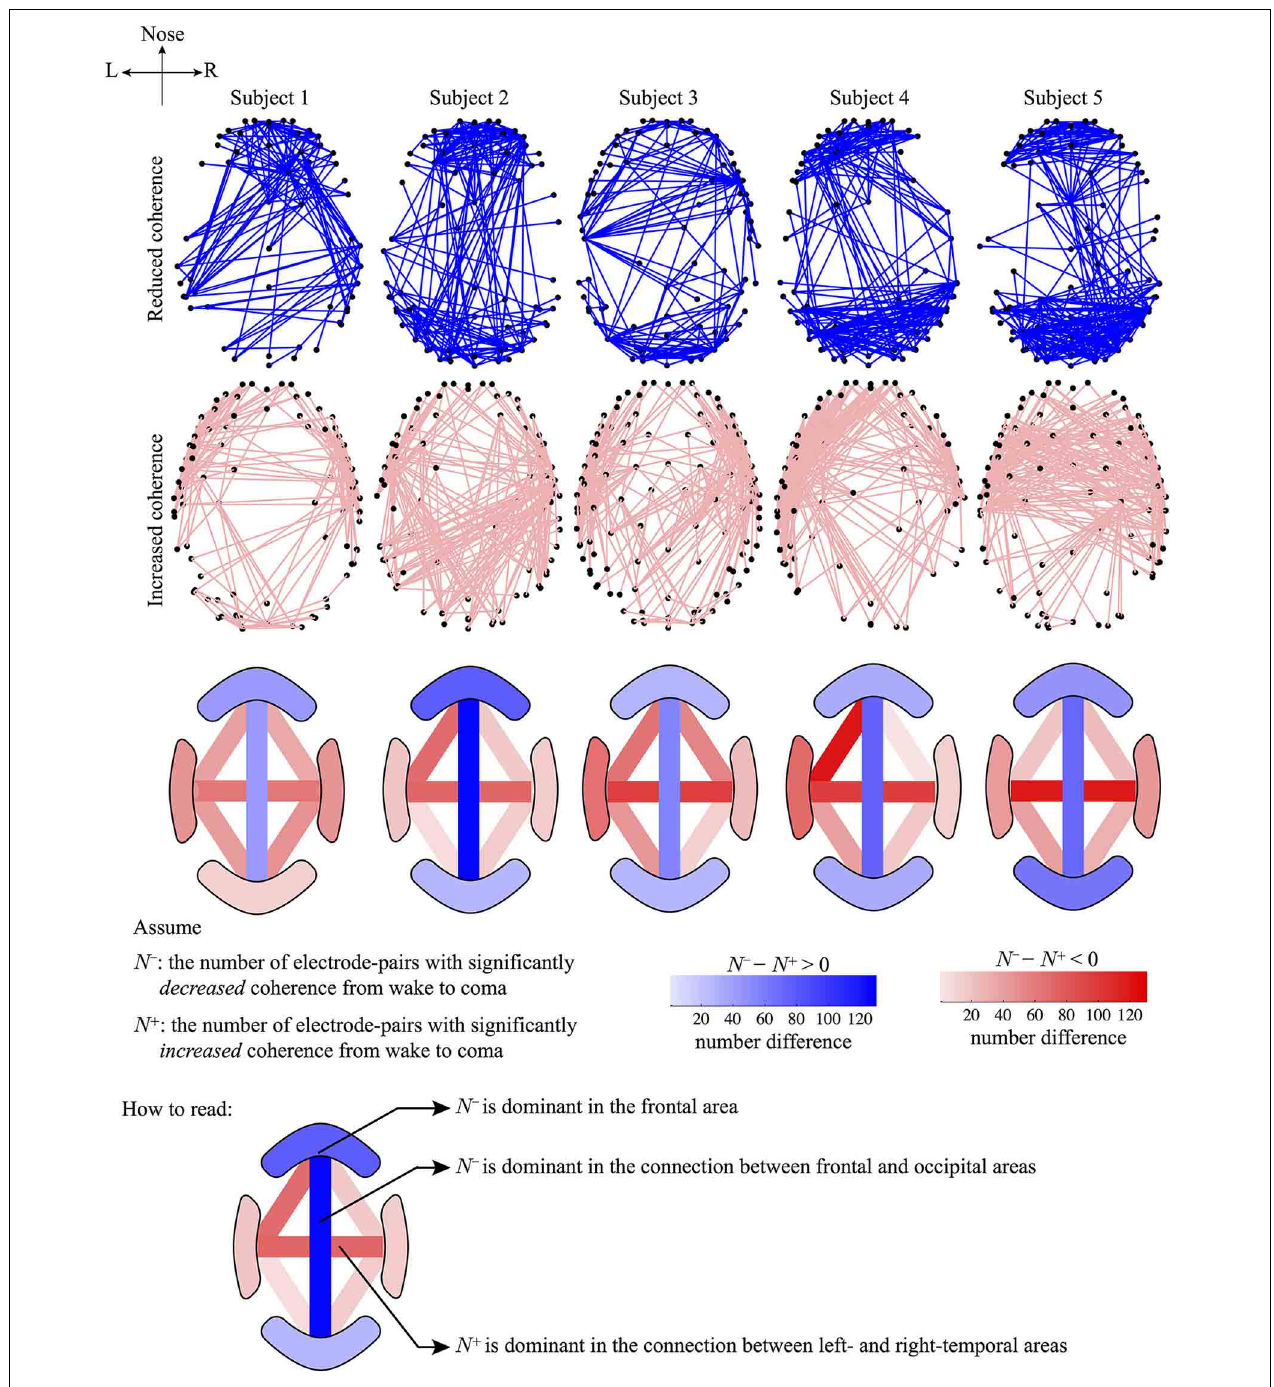
FIGURE 6 | Graphical representations of the electrode-pairs with significantly altered coherence from wake to coma for five subjects. The first and second rows represent electrode-pairs with significantly reduced (blue lines) or increased (pink lines) coherence, respectively: selected electrode-pairs correspond to the top 5% most changed (i.e., most increased or most decreased) coherence during the wake to coma transition. The third row describes the number difference of electrode-pairs between the first and second rows for four regions: frontal, occipital, left- and right-temporal; and for six pair-wise connections between regions: frontal–left temporal,